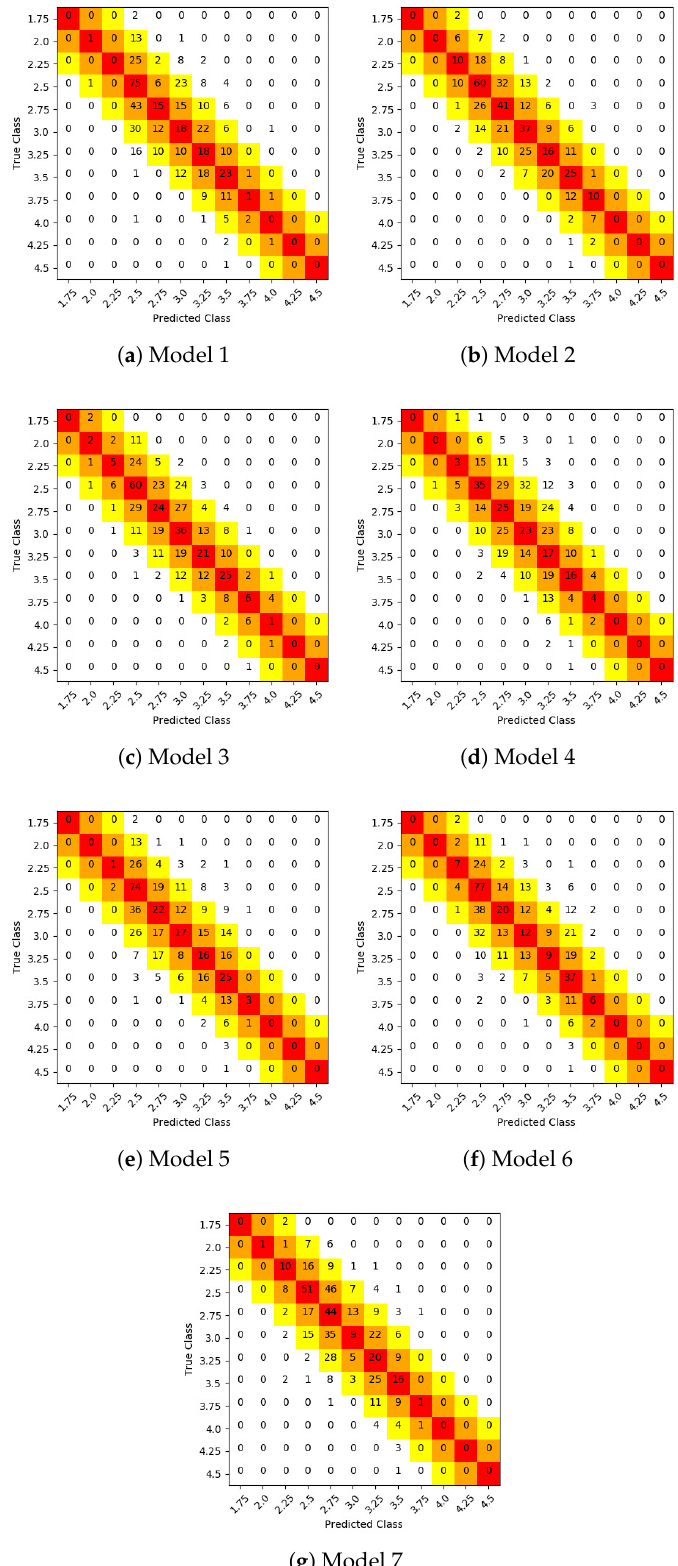
Figure 6. Confusion matrices of test samples classification. Red cells represent exact predictions, orange cells represent predictions with 0.25 units of error, and yellow cells represent predictions with 0.50 units of